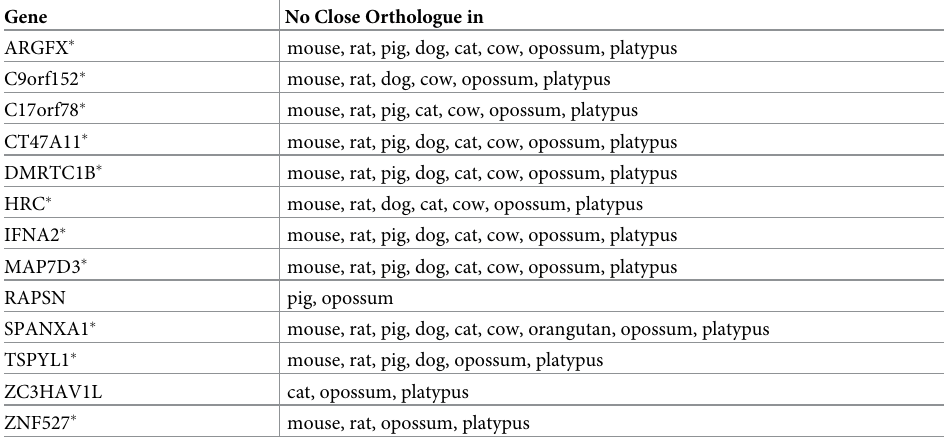
Table 3. Overall differences between 10 vertebrate species and human with respect to the 13 non-uniformly con- served human proteins in SMC only. ( � denotes absence of mouse orthologue, 11 out of